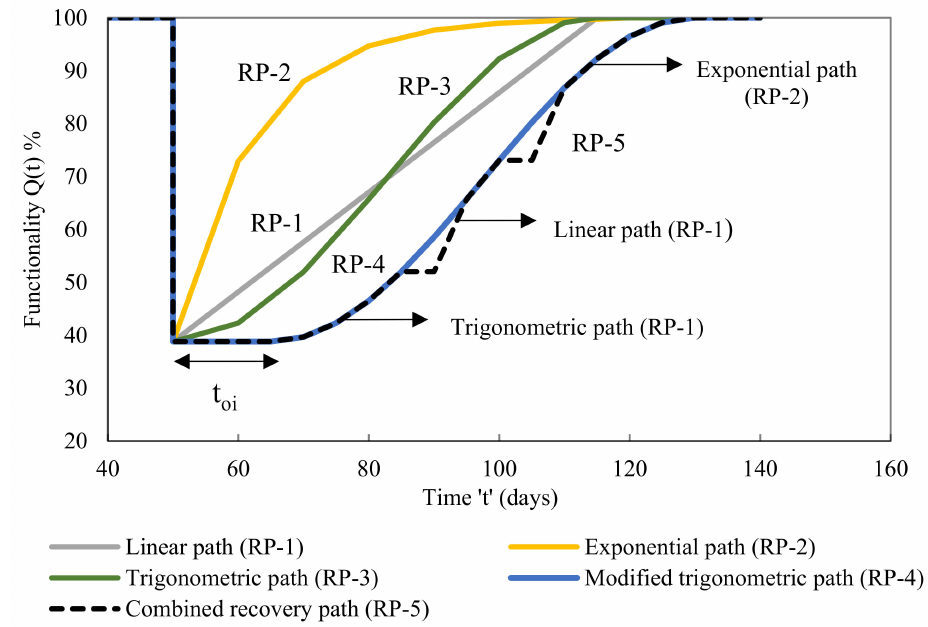
Figure 16. Various recovery paths considered (RP-1 to